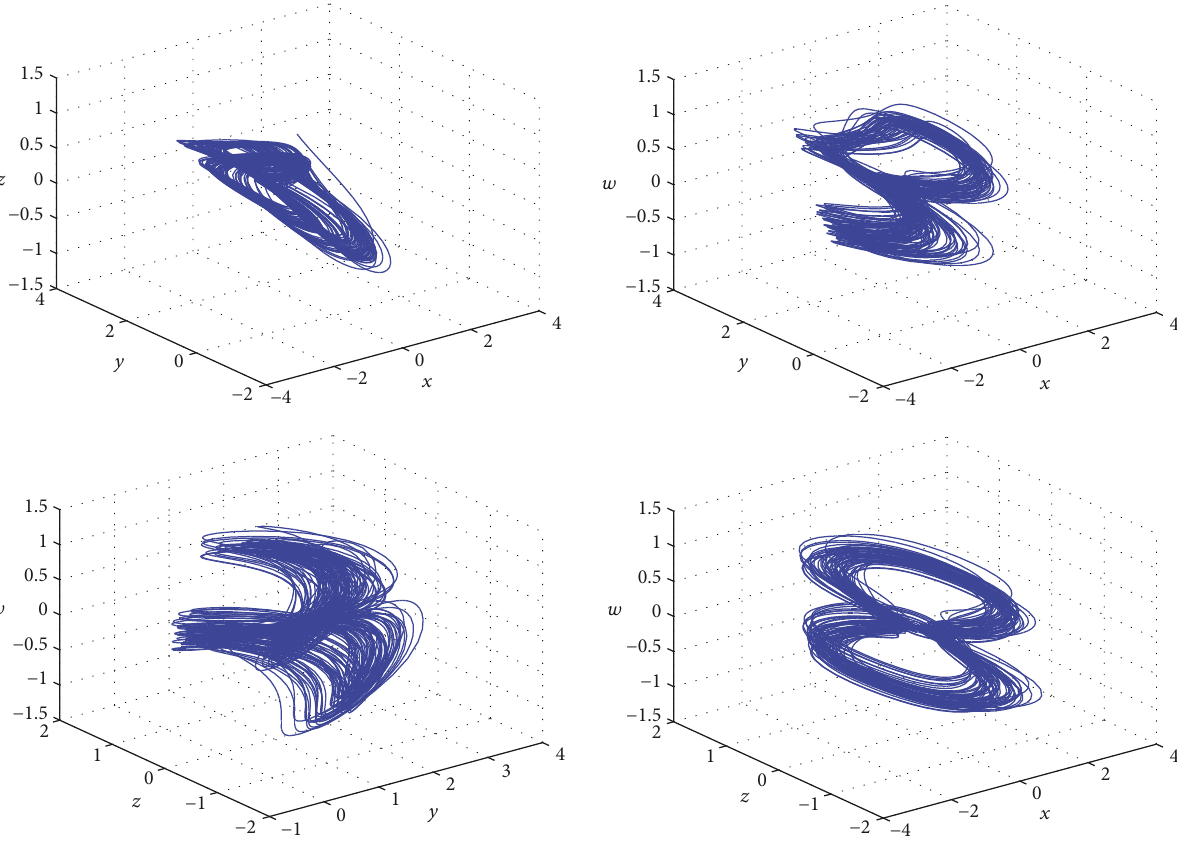
Figure 5: 3D projection of the strange attractor of system (1) on (𝑥,𝑦, 𝑧) -space, (𝑥,𝑦, 𝑤) -space, (𝑦,𝑧,𝑤) -space, and (𝑥,𝑤,𝑧) -space,